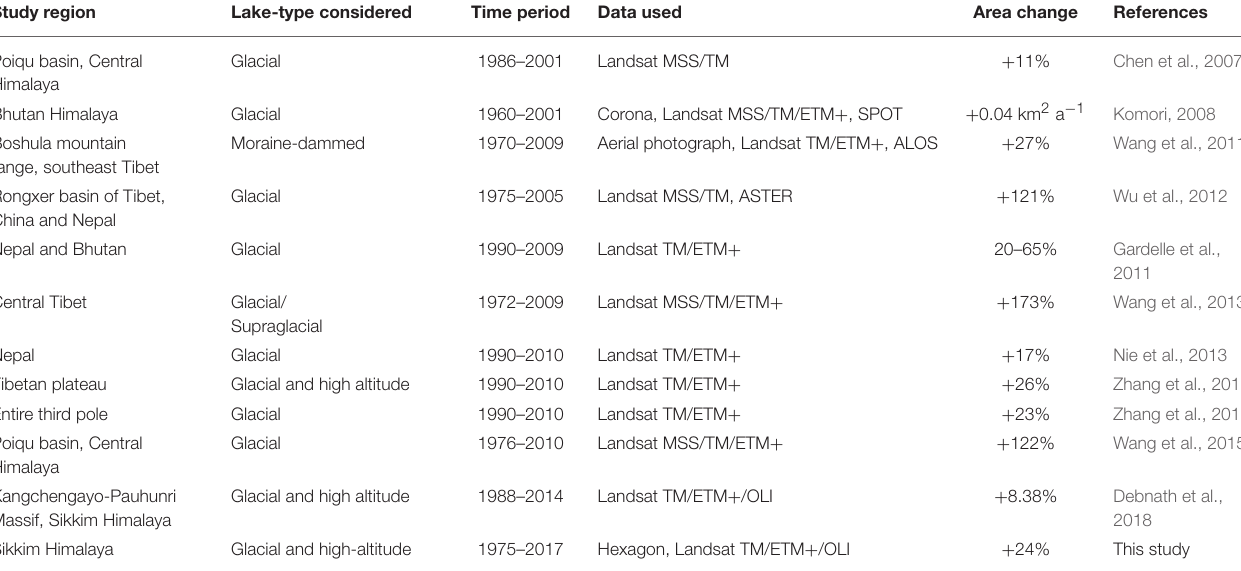
TABLE 7 | Lake growth rate reported in Tibet and Himalayan